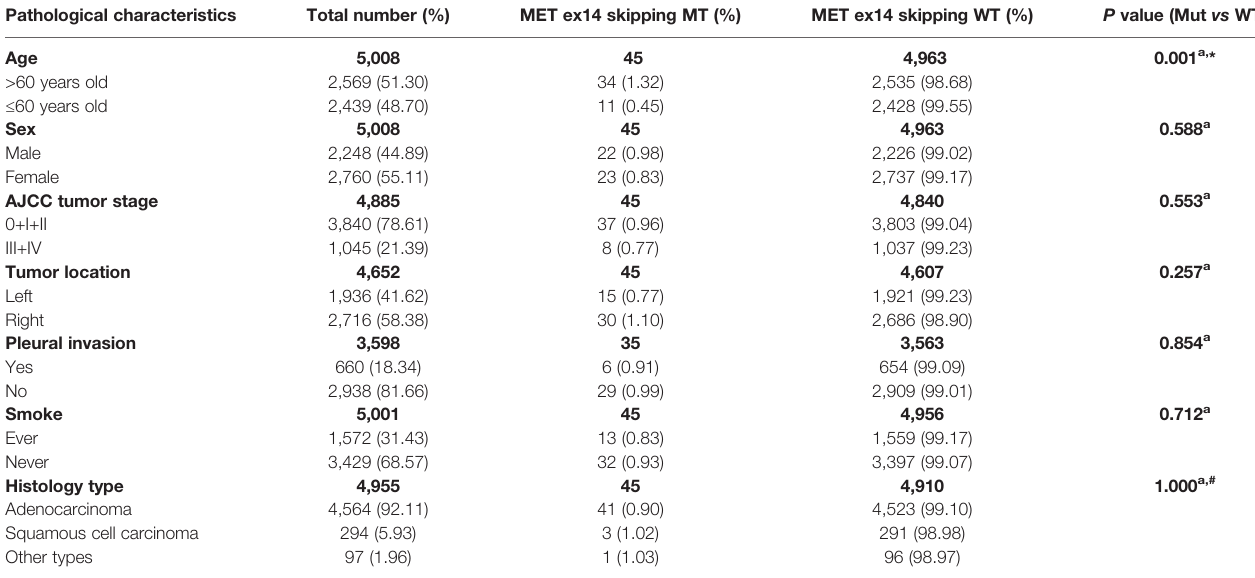
TABLE 2 | Clinicopathological characteristics and MET exon 14 skipping mutation. Pathological